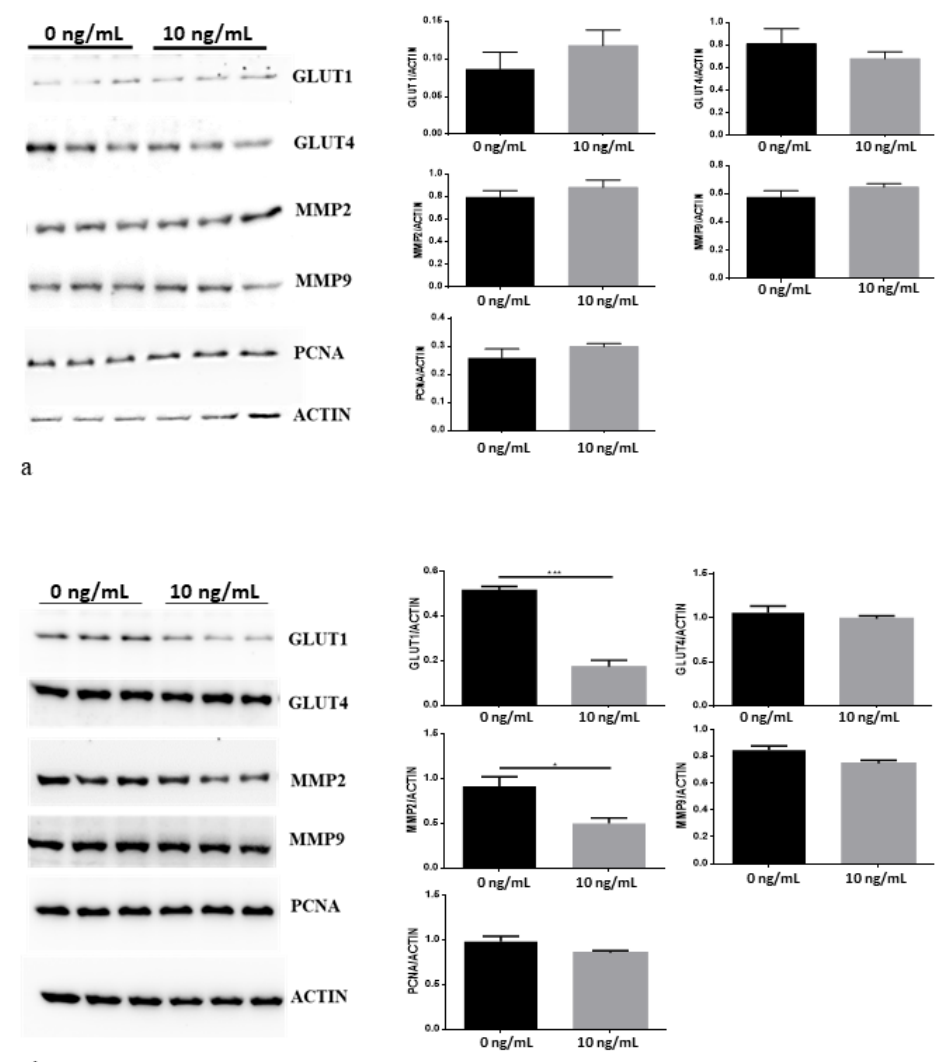
Figure 4. GLUT-1, GLUT-4, MMP-2, MMP-9 and PCNA expressions after treatment of LNCaP ( a ) and 22Rv1 ( b ) prostate cancer cell lines with 10 ng/mL rhCNTF for 24h. Bands were quantified and results were calculated in arbitrary units (AU) and reported as bars of a histogram. GLUT-1, GLUT-4, MMP-2, MMP-9 and PCNA expressions were normalized with β -actin expression. Data are represented as mean ± SD. * p < 0.05, *** p <0.001. Original images of immunoblotting data in the Figure S1.